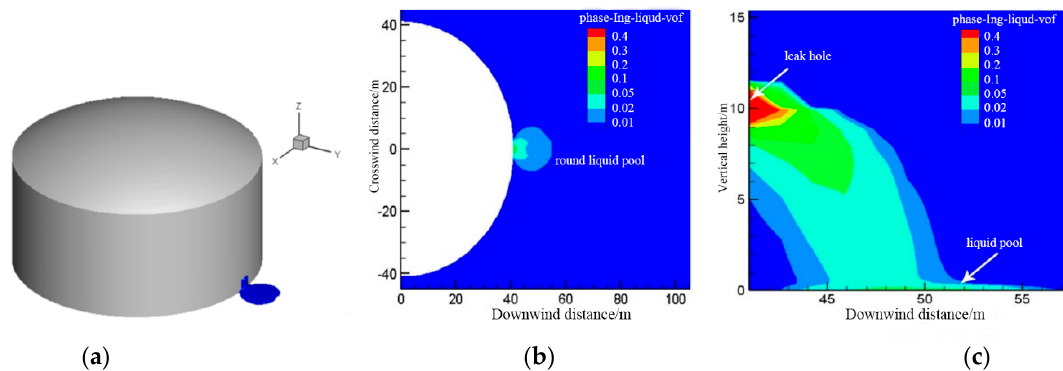
Figure 7. The distribution of LNG liquid pool. ( a ) Three-dimensional view of the liquid pool; ( b ) expansion of liquid pool at y = 0 m; ( c ) LNG injection at z = 0 m.